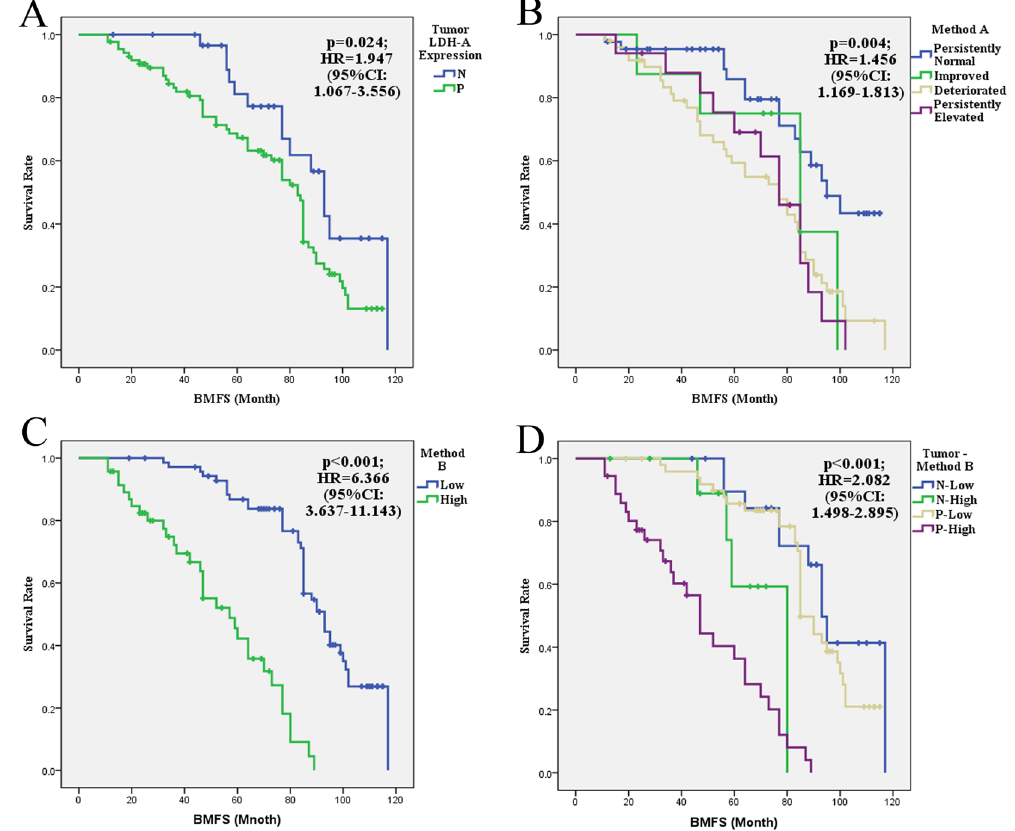
Figure 2. Kaplan–Meier curves for BMFS according to tumor LDH-A expression and serum LDH. ( A ) The Kaplan–Meier curves for BMFS according to tumor LDH-A expression; ( B ) according to serum LDH status determined by Method A; ( C ) according to serum LDH status determined by Method B and ( D ) according to the combination of tumor LDH-A expression and serum LDH status determined by Method B (P refers to the patients with LDH-A positive expression, N refers to the patients with LDH-A negative